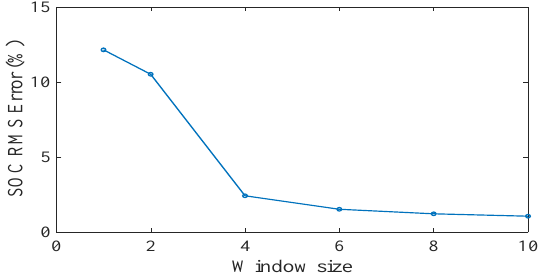
Figure 18. Effect of window size on the filter accuracy.